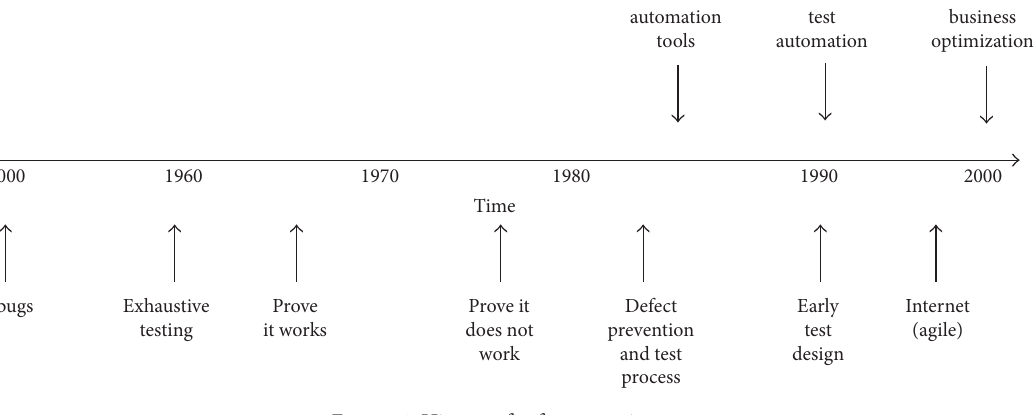
Figure 1: History of software testing.